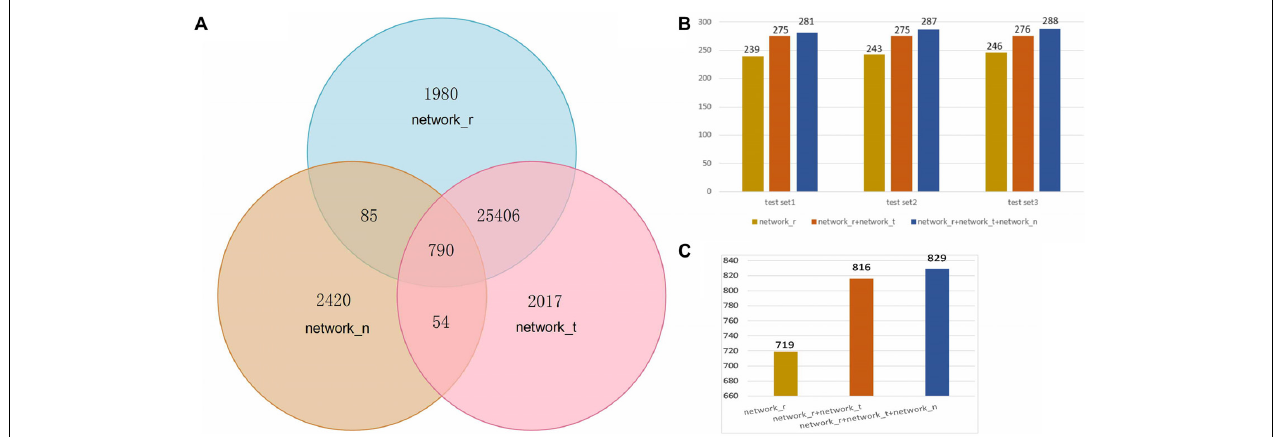
FIGURE 2 | (A) Statistics of nodes in three networks. Network_r: co-expression relations of RNA level; network_t: co-expression relations of translation level; network_n: relations of neighbors. (B) Numbers of predicted peptides in three test sets from three networks. (C) Numbers of predicted peptides in the global test data.